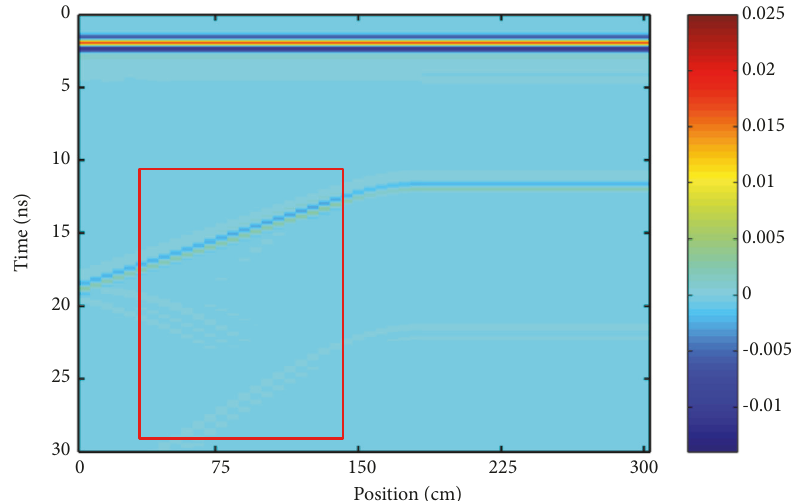
Figure 12: The wiggle trace profile of the embankment model simulated by the CUDA-implemented conformal SPRK